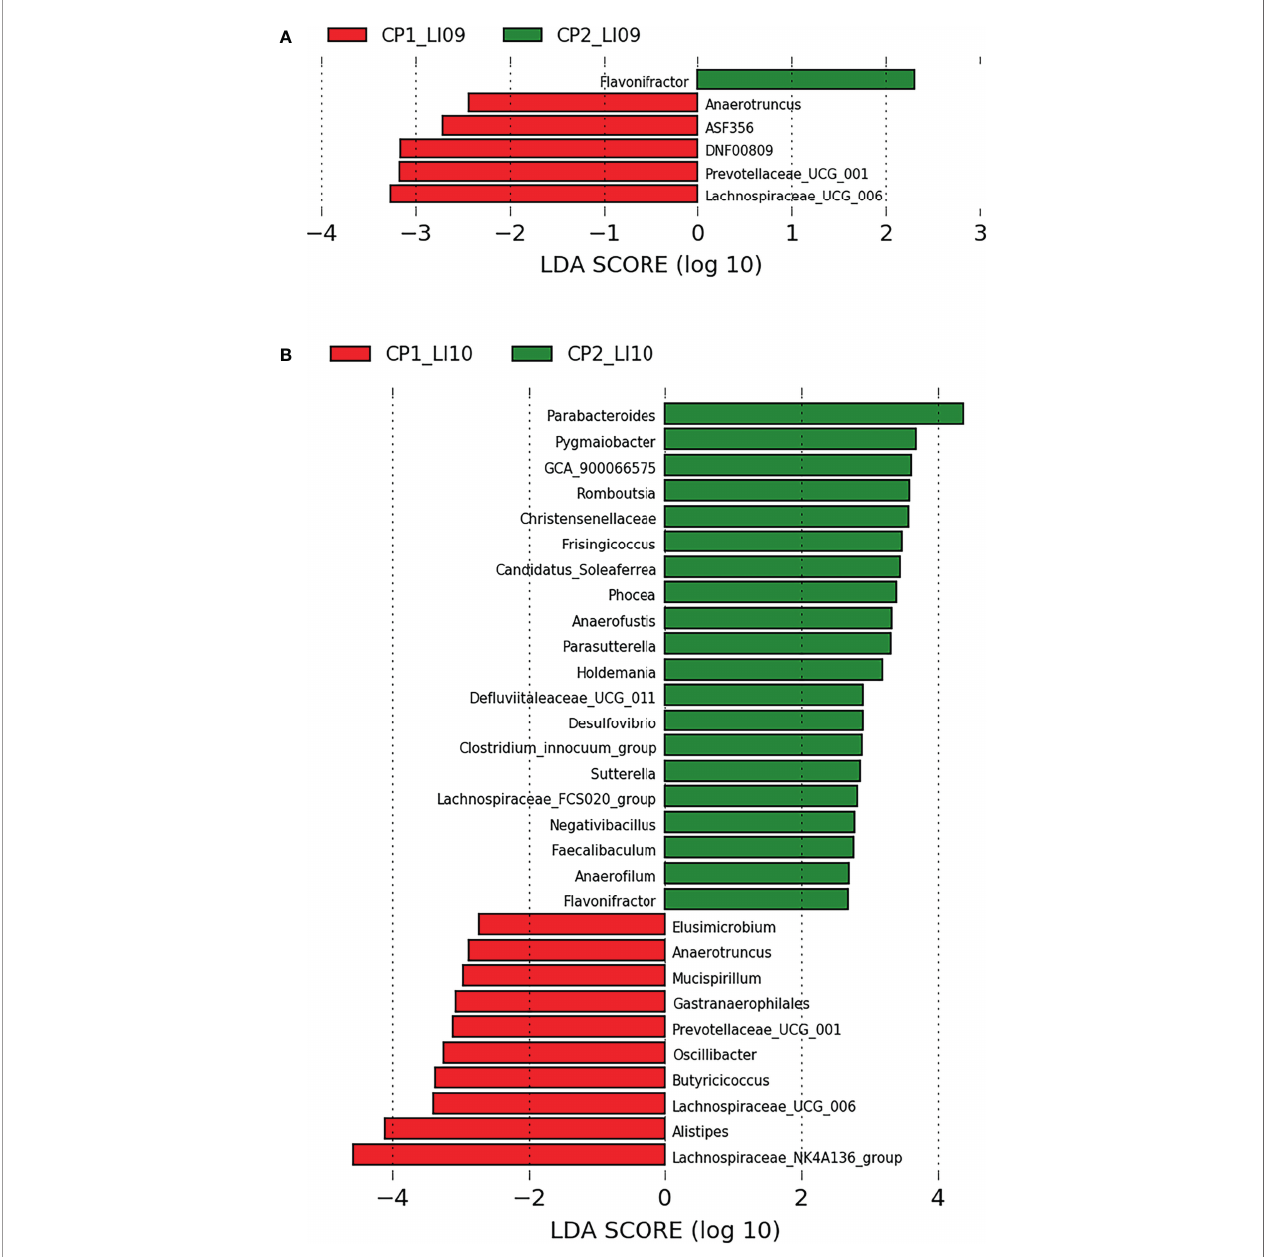
FIGURE 6 | LEfSe analysis determined the bacteria associated with (A) LI09 cohorts with different cytokine pro fi les (i.e., CP1_LI09 and CP2_LI09 cohorts) and (B) LI10 cohorts with different cytokine pro fi les (i.e., CP1_LI10 and CP2_LI10